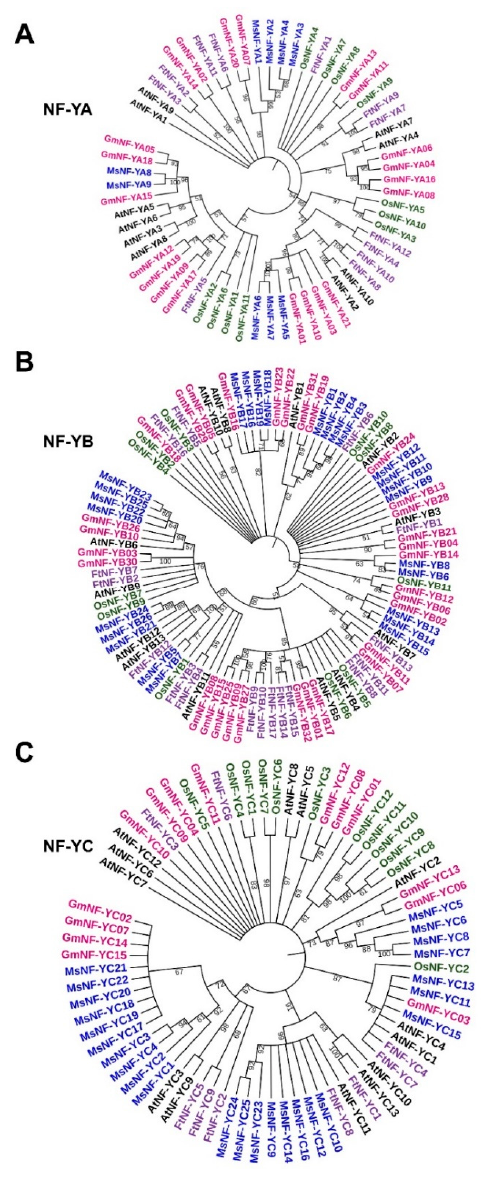
Figure 6. Phylogenetic relationship of NF-Y proteins from alfalfa, Arabidopsis , rice, soybean, and Tartary buckwheat. ( A ) NF-YA subfamily. ( B ) NF-YB subfamily. ( C ) NF-YC subfamily.